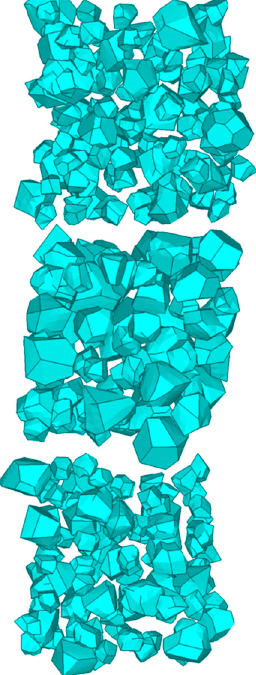
Figure 9. A generated model before free falling.